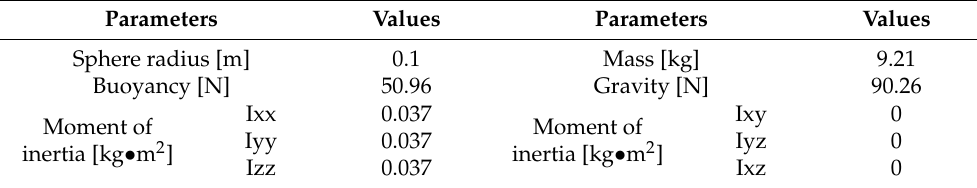
Table 3. Main parameters of the object. Parameters Values Parameters